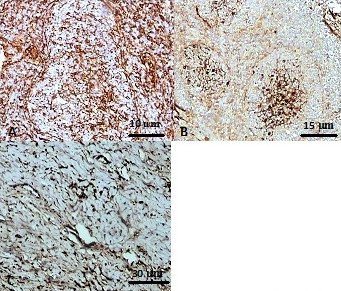
Immunohistochemical staining with, vimentin (A) and S-100 (B and C) are positive cells; the neoplastic cells in parts of the neurofibroma express S-100 and vimentin strongly.